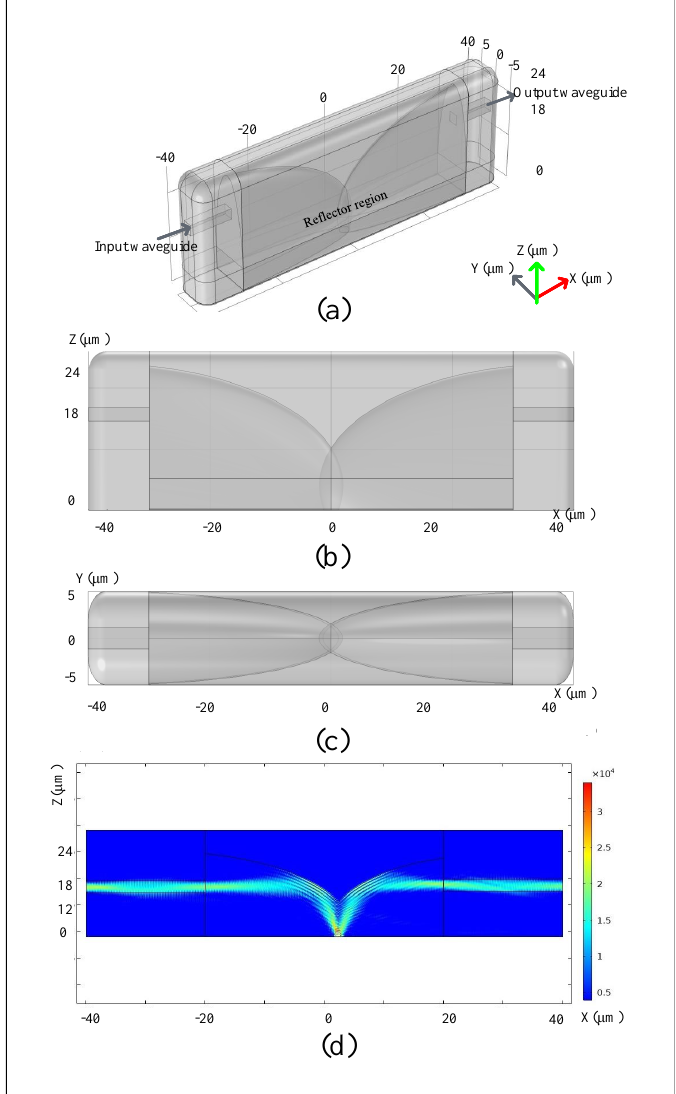
Figure 10. ( a ) 3D structure of Optical Free-Form Couplers for MQWs ERMs with a pair of parabolic reflectors. ( b ) Side view of this scheme. ( c ) Top view of this scheme. ( d ) Side view of FEM